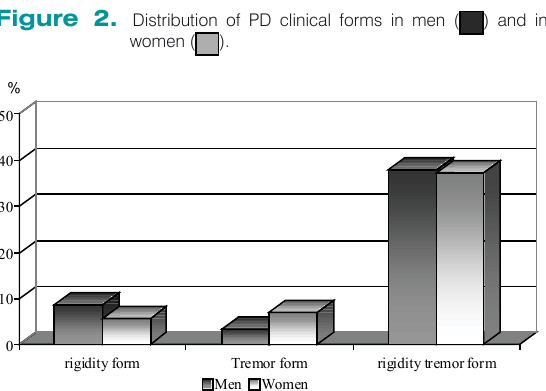
Figure 3. Diseases diagnosed for the patients with unconfirmed PD